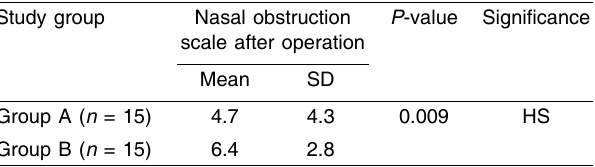
Table 7 Postoperative comparison of NOSE scores in the two groups